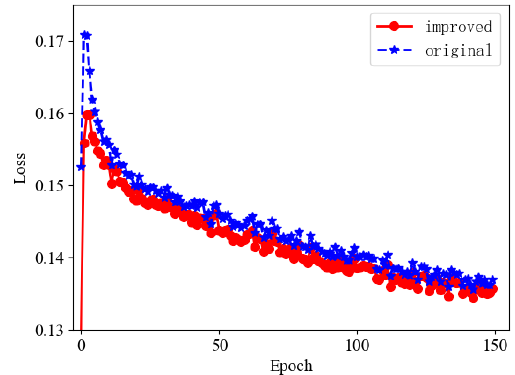
Figure 11. Comparison chart of the loss functions.